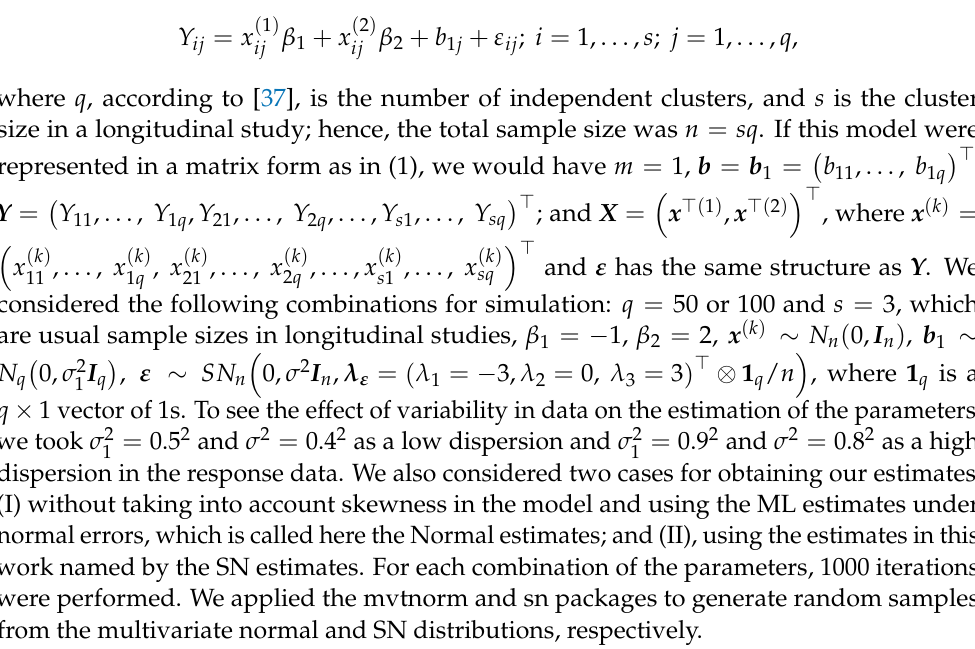
Table 1. Mean and SD of each estimator for both cases with n = 150, σ 2 = 0.4 2 and σ 2